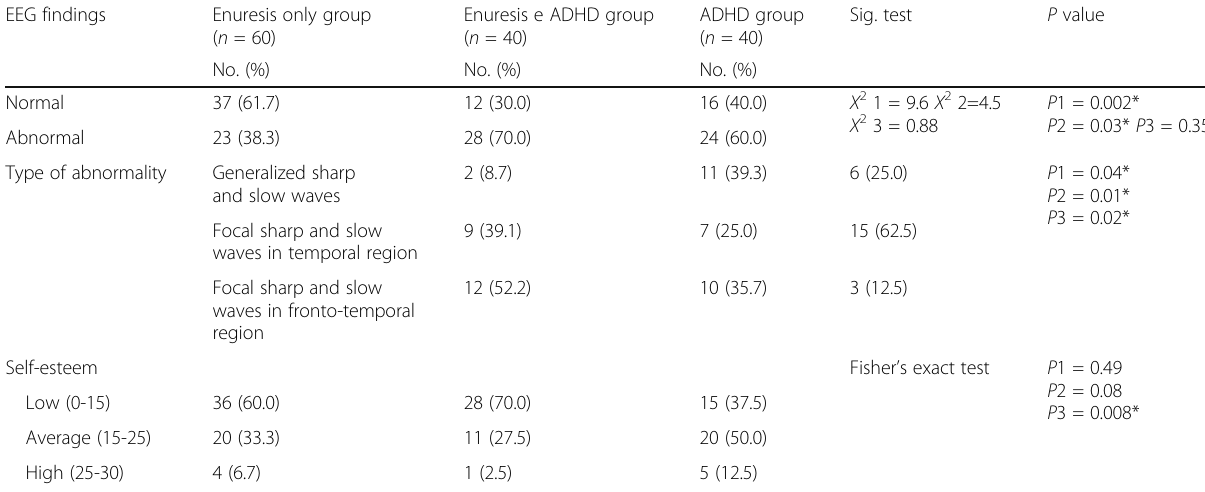
Table 3 EEG, self-esteem assessment of the three studied groups EEG